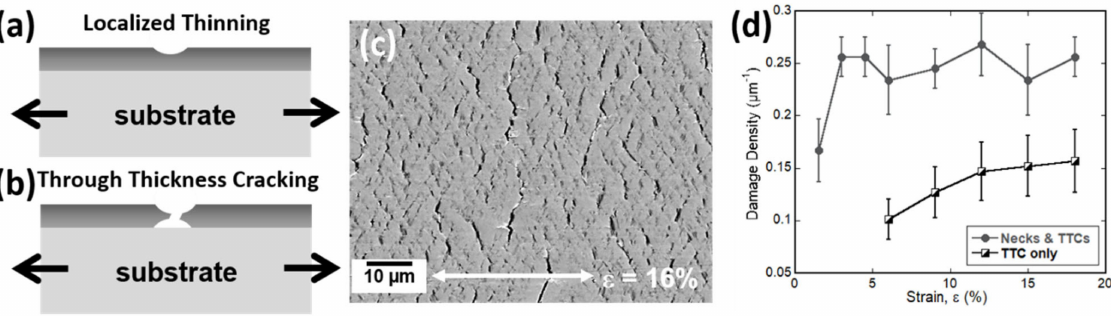
Figure 4. Schematic diagram of ( a ) localized thinning (also called necking) that first forms when a ductile metal film is strained. With continued straining ( b ) many of these areas will become TTCs. ( c ) SEM micrograph of 200 nm electron beam evaporated Cu film strained to 16% to illustrate localized necking and TTC formation (black lines) of the film. White arrow indicates the straining direction. ( d ) TTC and damage evolution of a 200 nm Cu/10 nm Cr bilayer film system roll-to-roll sputter deposited on PET. The combined damage density of necks and TTC spacing is higher and starts before TTC cracks